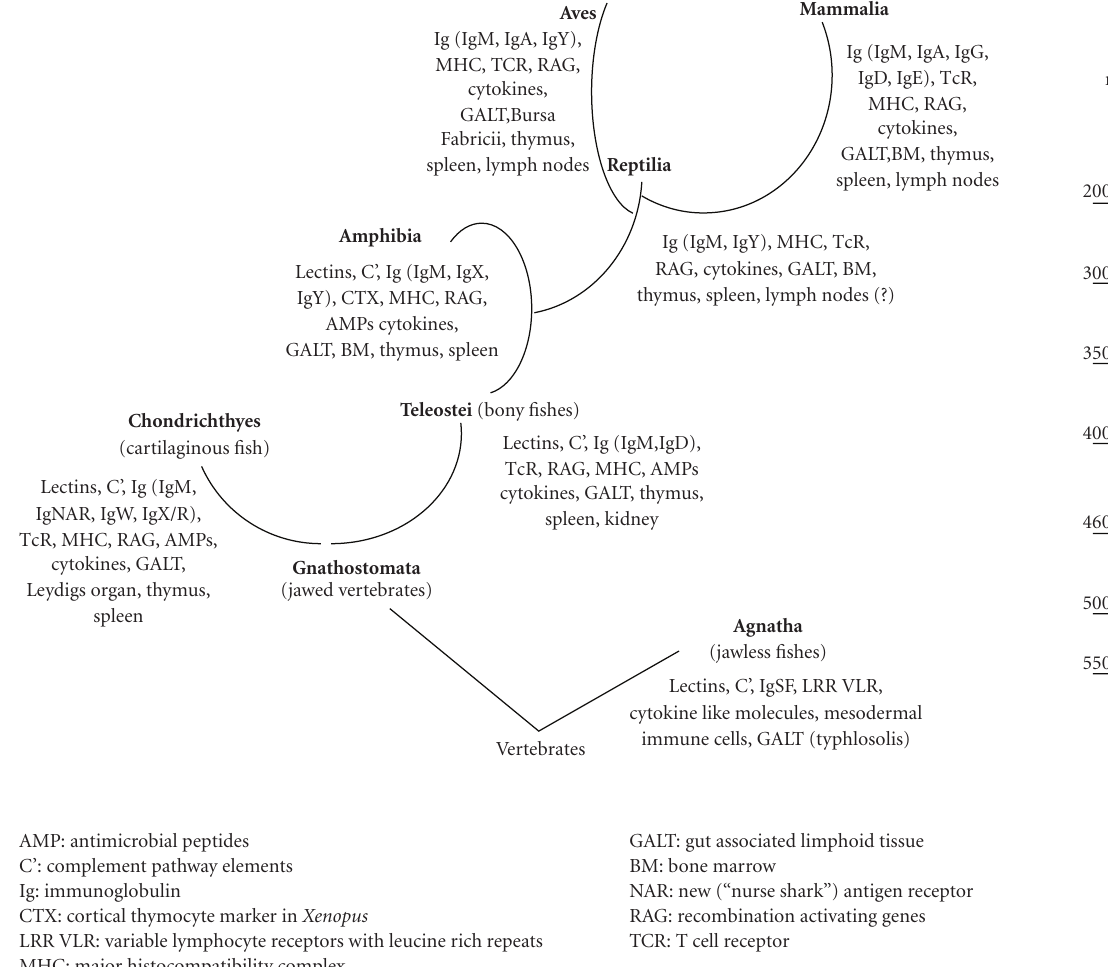
Figure 2: Evolution of molecular and histological structures of the vertebrate immune system. Regarding lymphatic tissues, the thymus, and spleen appeared early in fishes, while lymph-filtering lymph nodes are observed only in birds and mammals. Among the development of various immunoglobulin isotypes, IgD is expressed in bony fishes, later only mammals are using this B-cell receptor